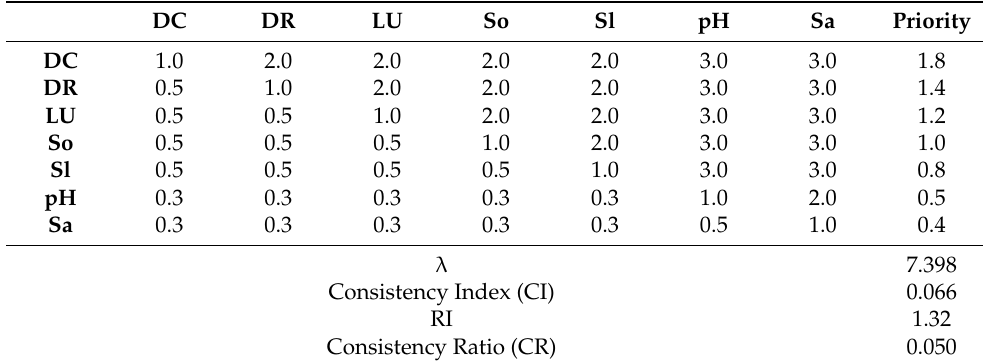
Table 1. Analytical hierarchy process (AHP) judgment matrix and consistency ratio assessment.